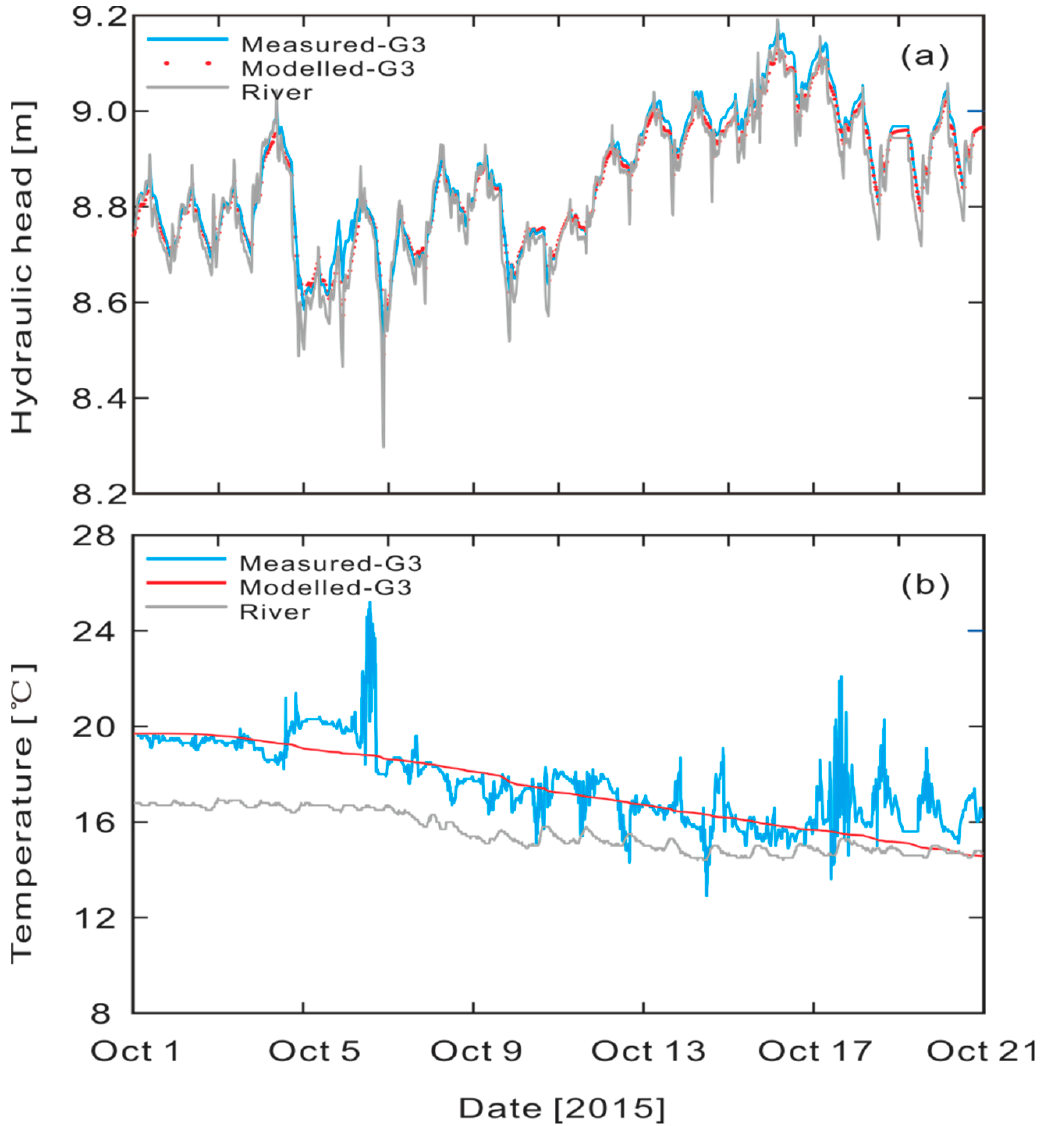
Figure 2. The comparison between the measured and modelled hydraulic heads ( a ) and water temperature ( b